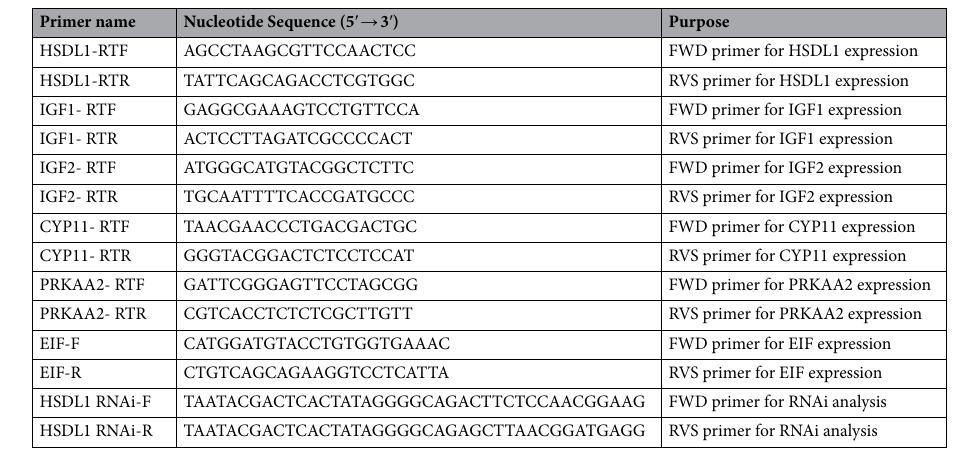
Table 3. Primers used for HSDL1